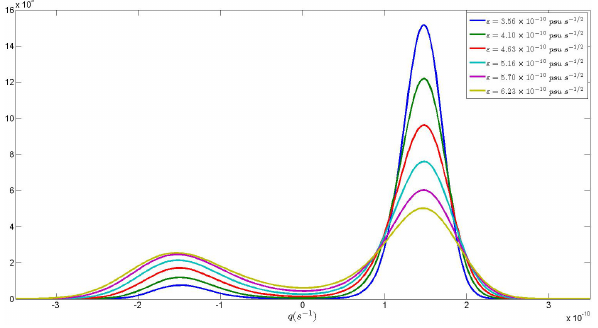
Fig. 5. Empirical probability distribution function for the THC strength in the 2 d.o.f. model with noise applied only in box 1.